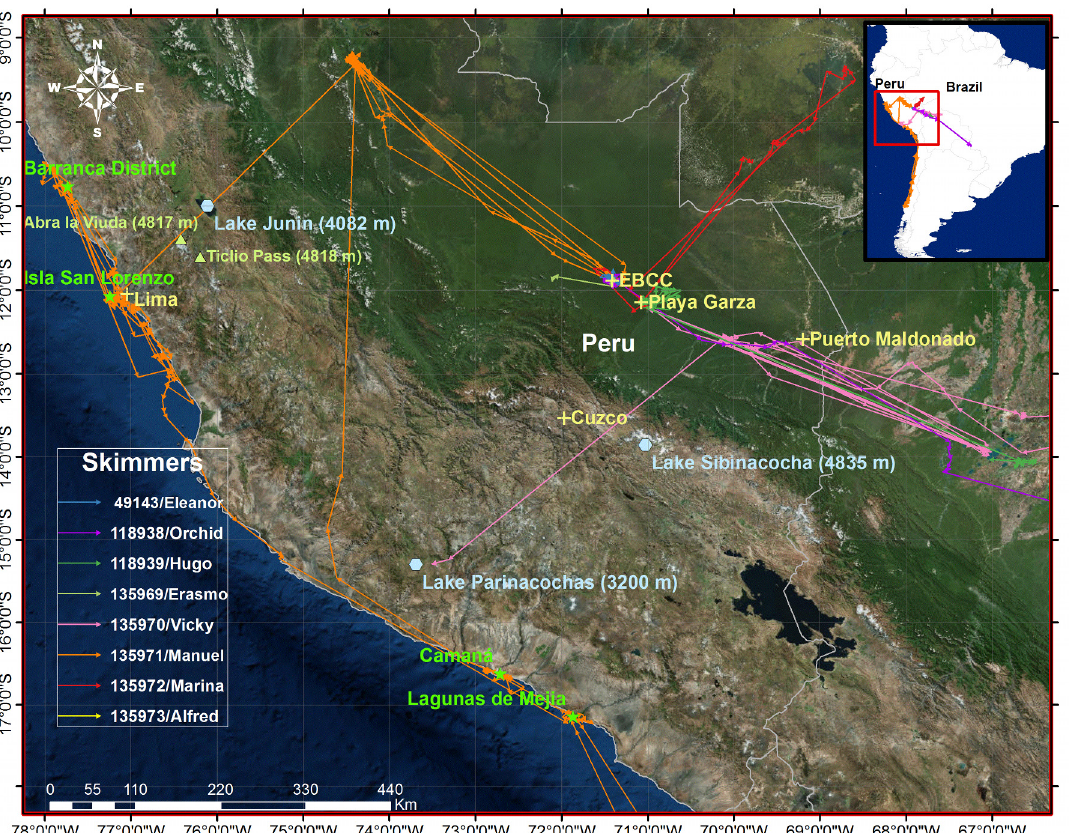
Fig 2. Trans-Andes migration routes used by two Manu Black Skimmers. Routes of Manuel (orange) and Vicky (pink) depict the varied routes used for the 3 Andean crossings tracked for two skimmers. Created with ESRI ArcGIS 10.2.2 software. Basemap data sources include: DigitalGlobe,